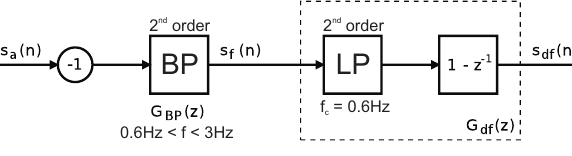
Fig.6: Filter for detection of maxima of s a ( n )